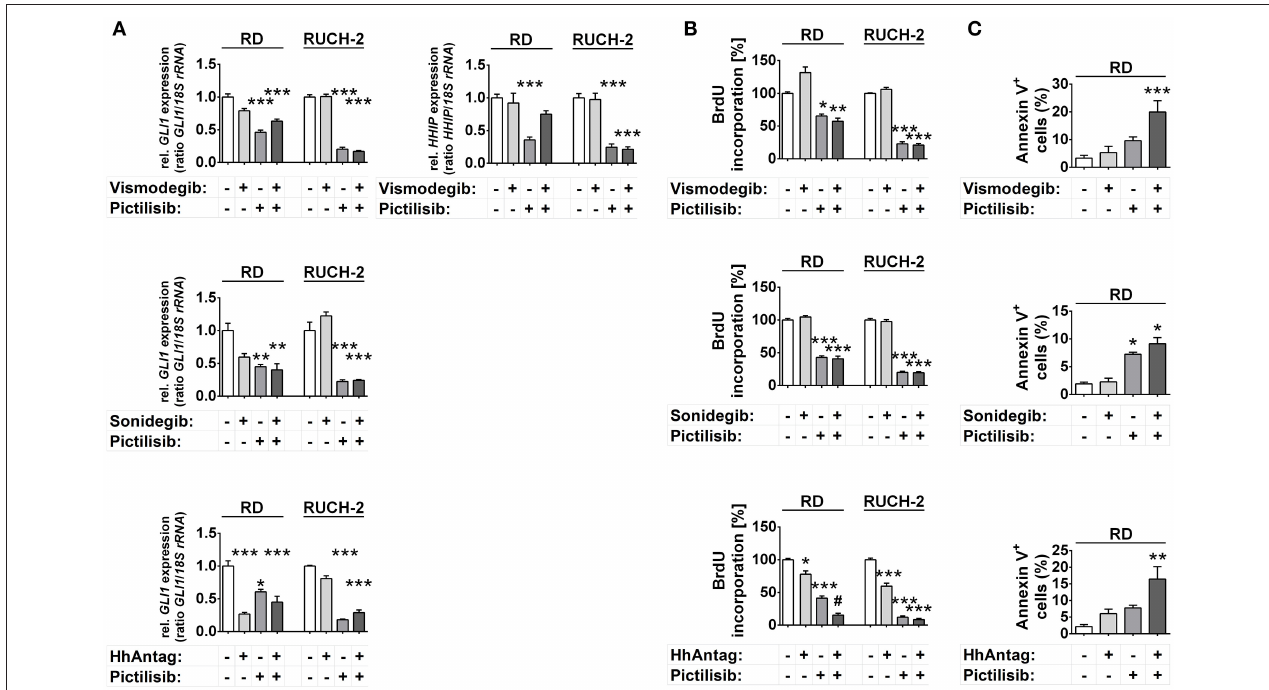
FIGURE 3 | Effects of SMO and/or PI3K inhibition on HH target gene expression, proliferation and apoptosis in human ERMS cell lines. RD and RUCH-2 cells treated with 10 µ M of SMO inhibitors and/or 10 µ M of the PI3K inhibitor pictilisib. (A) GLI1 expression levels after treatment for 24h. HHIP expression was investigated after treatment with vismodegib and/or pictilisib (B) BrdU incorporation after treatment for 24h. BrdU incorporation of solvent treated cells was set to 100%. Bars represent the mean + s.e. of three independent experiments performed in triplicates. (C) Annexin V staining and subsequent FACS analysis of RD cells treated for 48h with the drugs as indicated. Bars represent the mean number of Annexin V + cells + s.e. of two independent experiments performed in duplicates.* P < 0.05, ** P < 0.01, *** P < 0.01 compared to cells treated with solvent and analyzed by Tukey’s test for multiple comparisons. # P < 0.05 compared to cells treated with either drug alone.